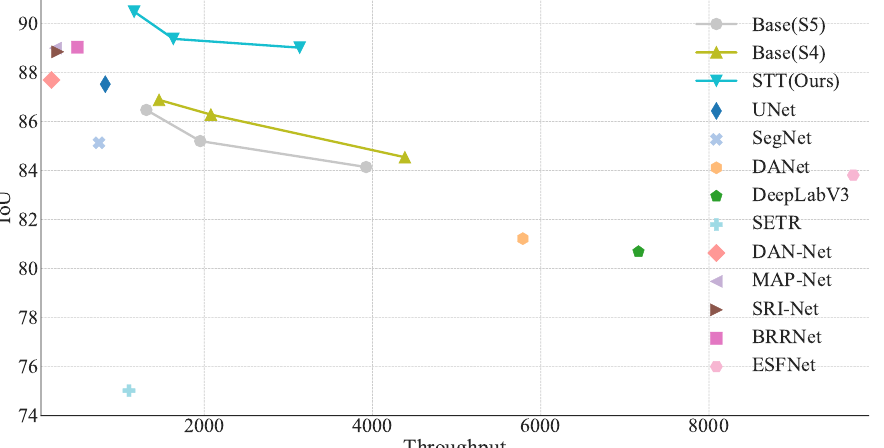
Figure 1. Throughput (images with 512 × 512 pixels per second on a 2080Ti GPU) versus accuracy (IoU) on WHU aerial building extraction test set. Here, we only calculate the model inference time, not including the time to read images. Our model (SST) outperforms other segmentation methods with a clear margin. For STT, Base (S4), and Base (S5), points on the line from the left to the right refers to the models with different CNN feature extractor of ResNet50, VGG16 and ResNet18,